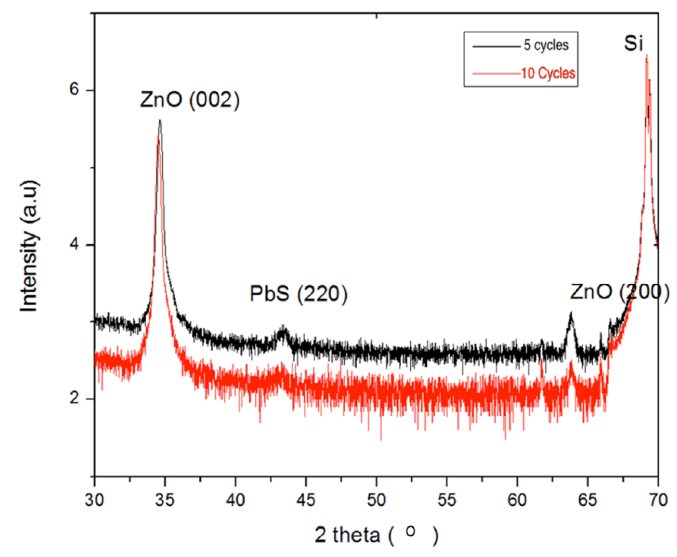
Figure 9. XRD pattern of ZnO/PbS heterojunction: 5 cycles and 10 cycles.